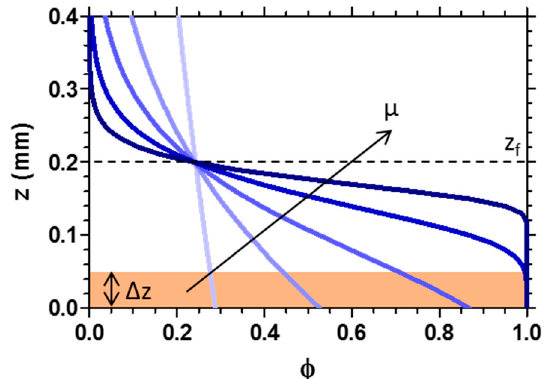
Figure 5. Conversion φ profiles along the sample depth z for increasing attenuation coefficient μ . The position of the photopolymerising front z f is fixed equal to 200 μ m, and the printing layer thickness Δ z is set as 50 μ m.